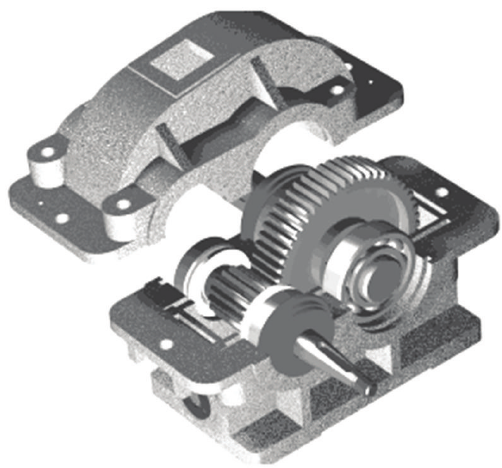
Figure 2: Gear transmission model of one-level reducer.